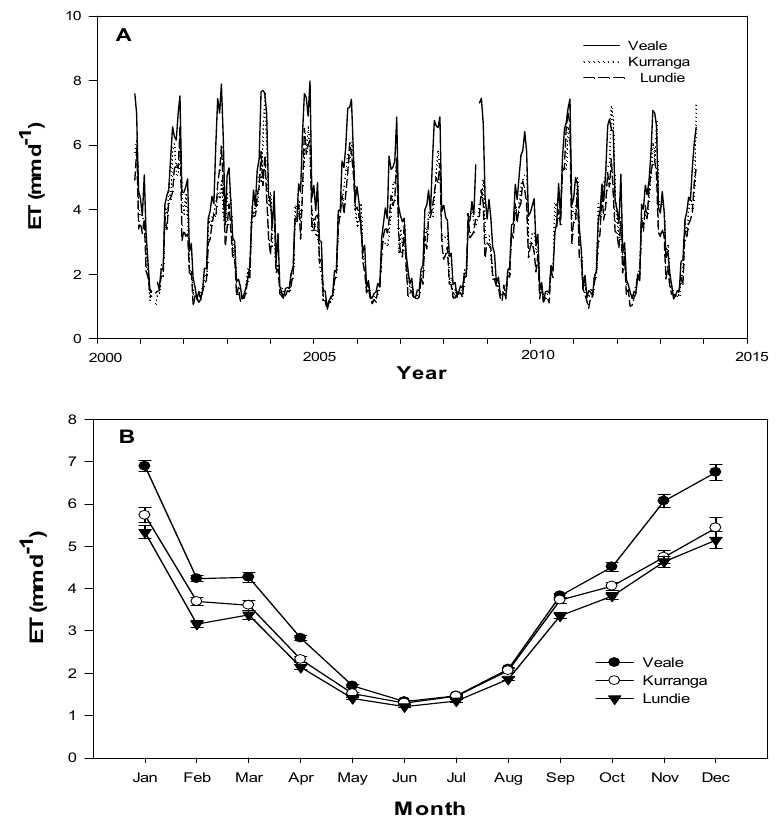
Figure 5. ( A ) ET estimated by MODIS EVI at 16-day intervals, 2000 to 2013, for three adjacent park areas in Adelaide, Australia; ( B ) Monthly ET values averaged over all years for the same sites. Error bars are standard errors over years.